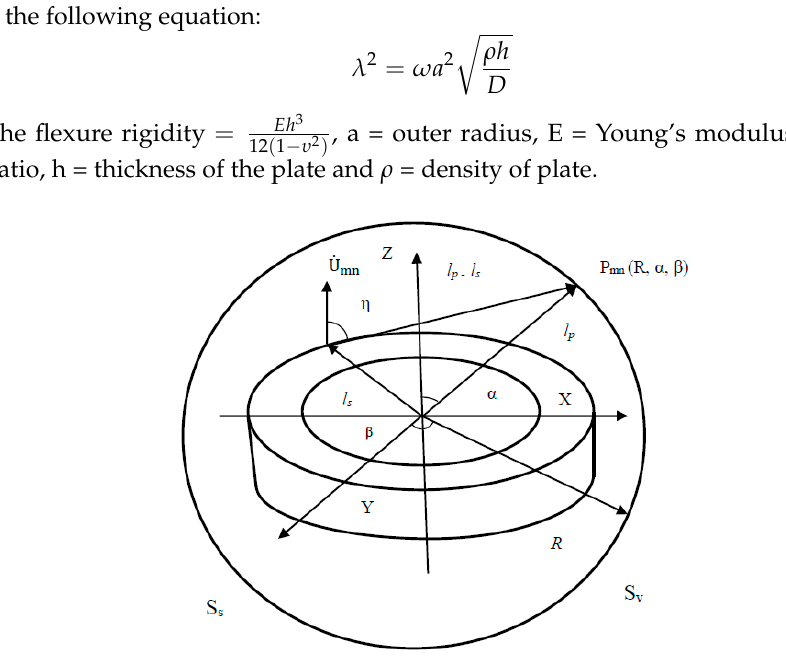
Figure 1. Sound radiation investigated for thick annular circular plate in Z direction enclosed in a sphere.